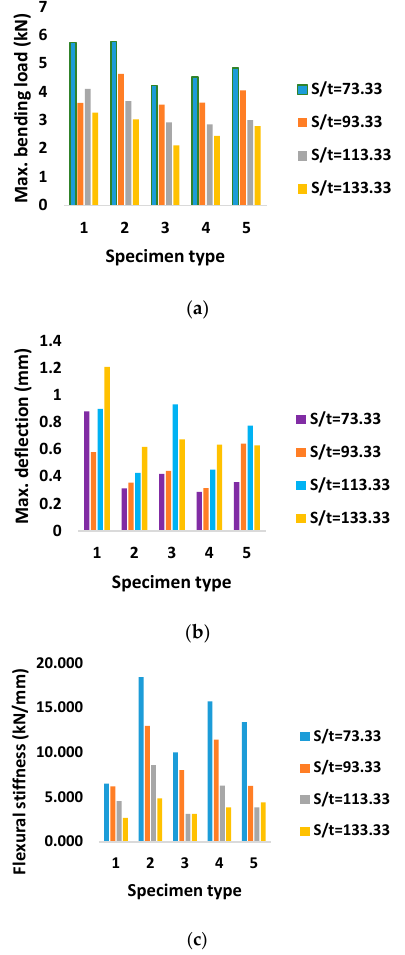
Figure 3. Experimental flexural performance measures ( a ) Maximum bending load ( b ) maximum deflection and ( c ) Flexural stiffness. Table 4. Numerical flexural performance